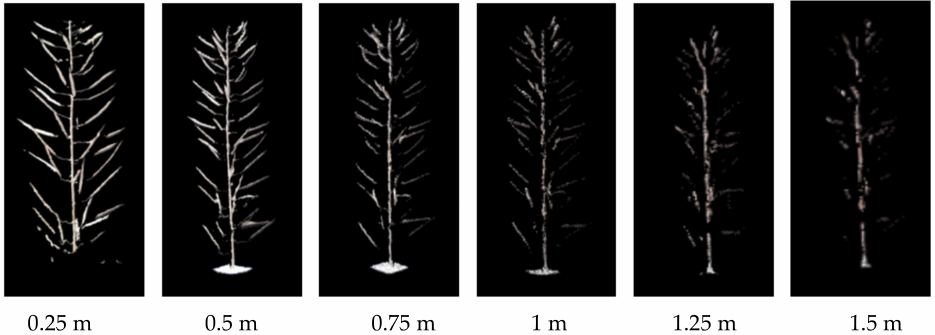
Figure 7. Comparison of silique point clouds at different shooting